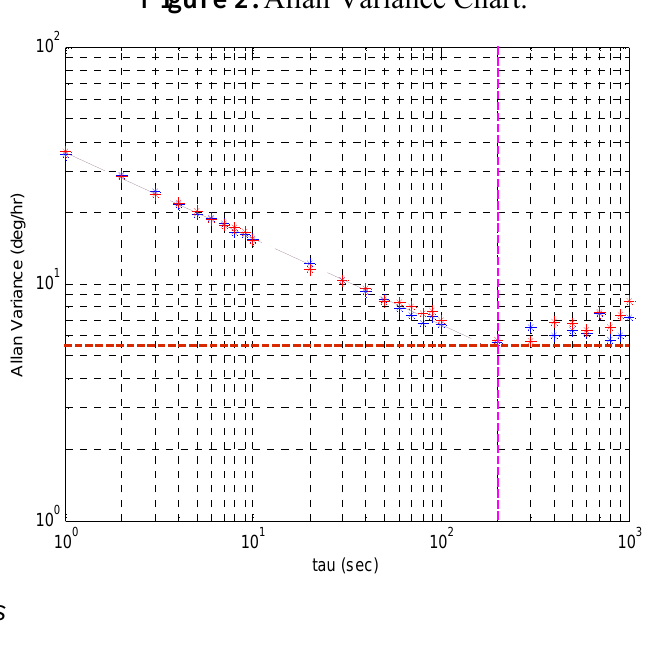
Figure 2. Allan Variance Chart.